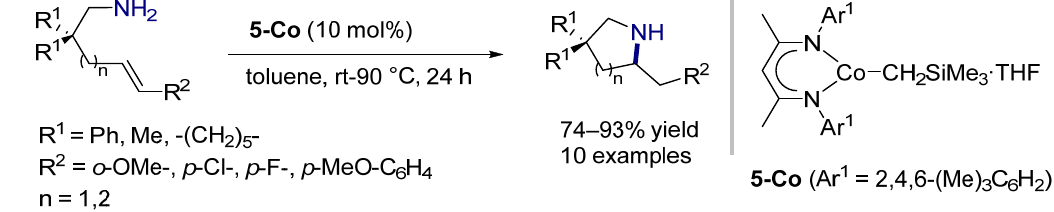
Figure 15. Well-defined β -diketiminatocobalt(II) alkyl-catalyzed hydroamination of primary amines tethered to alkenes.